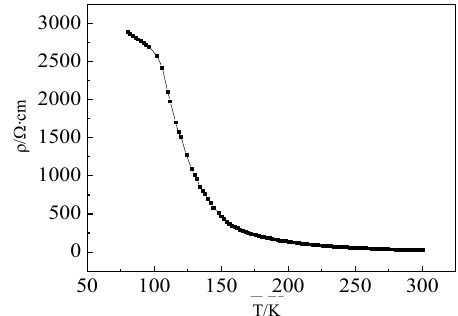
FeMoO . Figure 2. Temperature dependence ( T ) of 2 6 resistivity ( ρ